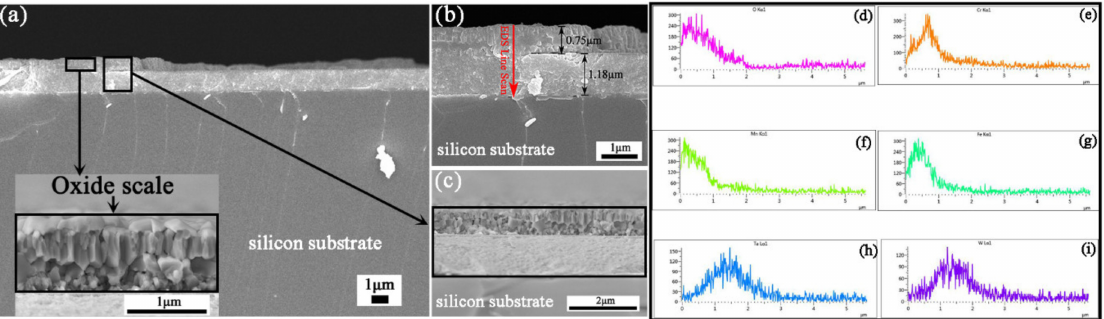
Figure 4. ST3 specimen: ( a – c ) Cross-section images; ( d – i ) EDS line scan of cross-section of the coating after being oxidized. The line scan followed the direction of the red arrow in ( b